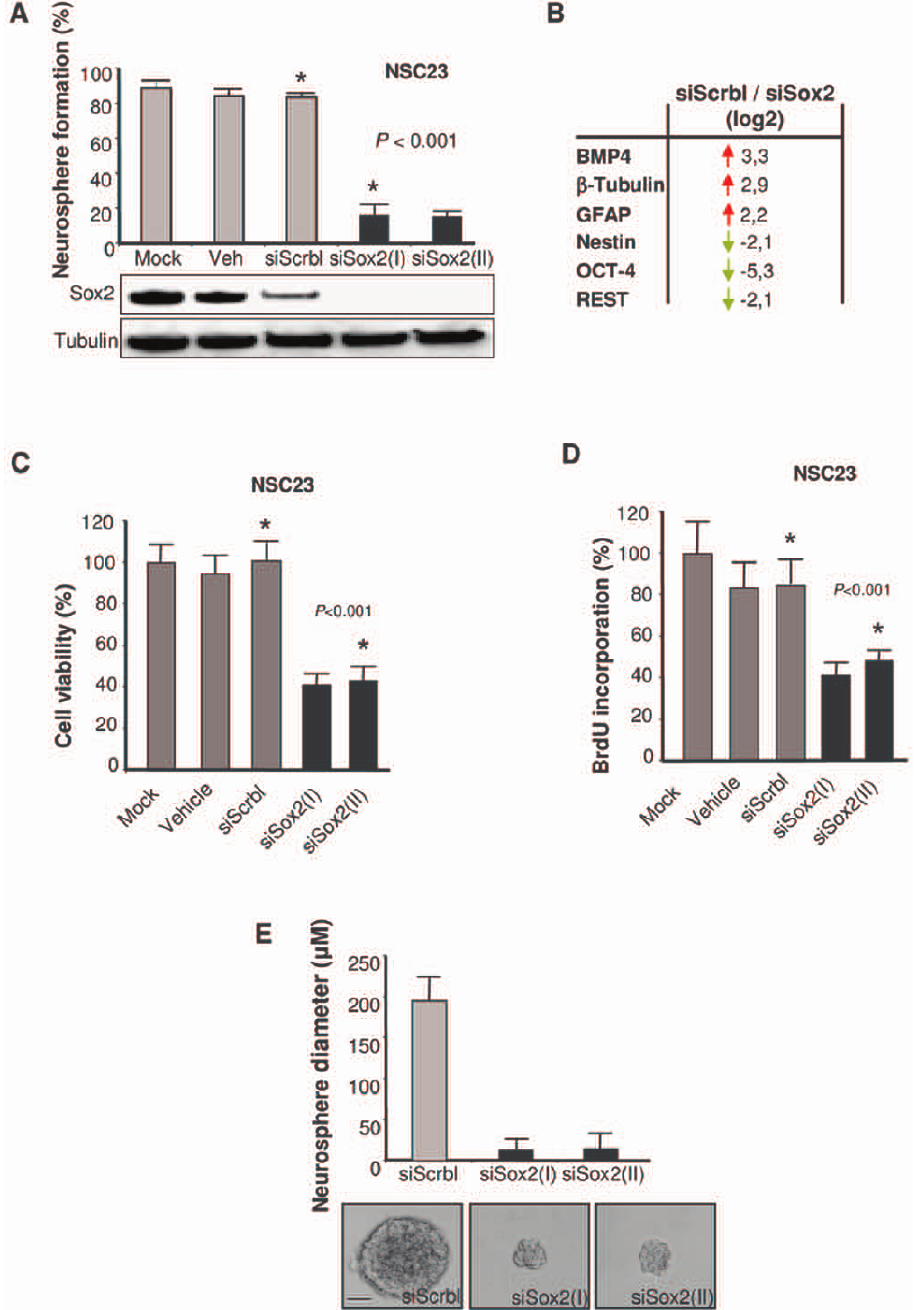
Figure 4. Role of Sox2 in self-renewal properties of GBM. A. Role of Sox2 in the self-renewal capabilities of BTSCs. Upper panel, quantification of neurosphere formation percentage in Sox2-silenced NSC23 BTSC line. NSC23 cells were transfected with mock, vehicle (Veh), siRNA scramble (siScrbl), or two different siRNAs against Sox2, Sox2 (I) and Sox2 (II), and the number of secondary spheres generated was assessed after 8–10 days. To confirm that the spheroids were, indeed, formed by stem cells, we randomly selected at least 15 individual secondary spheres and subjected them to further, long-term (2 months) propagation in each subcloning experiment. Lower panel, representative western blot of Sox2-silenced NSC23 cell line. B. Assessment of differentiation/stem cell markers in Sox2-silenced BTSCs. The expression values of the markers were expressed as the log2 ratio of the Sox2-silenced sample (siSox2) versus the siScramble-transfected sample (siScrbl). Data shown are from one representative experiment. C. Cell viability analysis in Sox2-silenced BTSCs. Cell viability was examined 7 days later by MTT assay. D. Cell proliferation analysis in Sox2-silenced BTSCs. Cell proliferation was evaluated by measuring the BrdU incorporation and expressed as a percentage of the mock-treated cells. E. Neurosphere size evaluation in Sox2-silenced BTSCs. Upper panel, Quantification of the diameter of NSC23 neurosphere transfected with siScrbl or two different siRNAs against Sox2, Sox2(I) and Sox2(II). Lower panel, representative micrographs of neurosphere size are depicted (50 m m magnification).